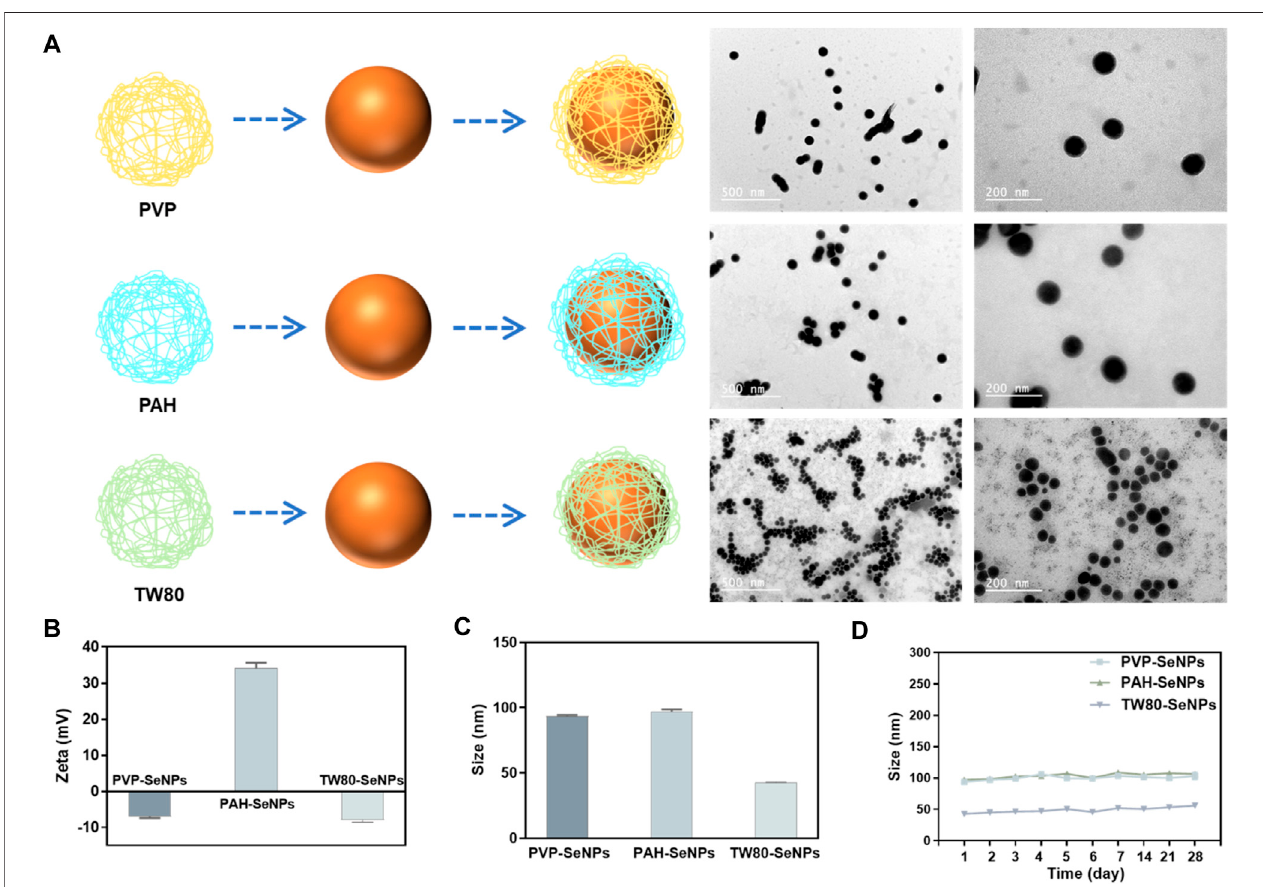
FIGURE 1 | Synthesis and characterization of different functionalized SeNPs. (A) Synthesis and TEM images of functionalized SeNPs. (B) and (C) Zeta potential and size of different SeNPs. (D) Stability of different SeNPs in aqueous solution.